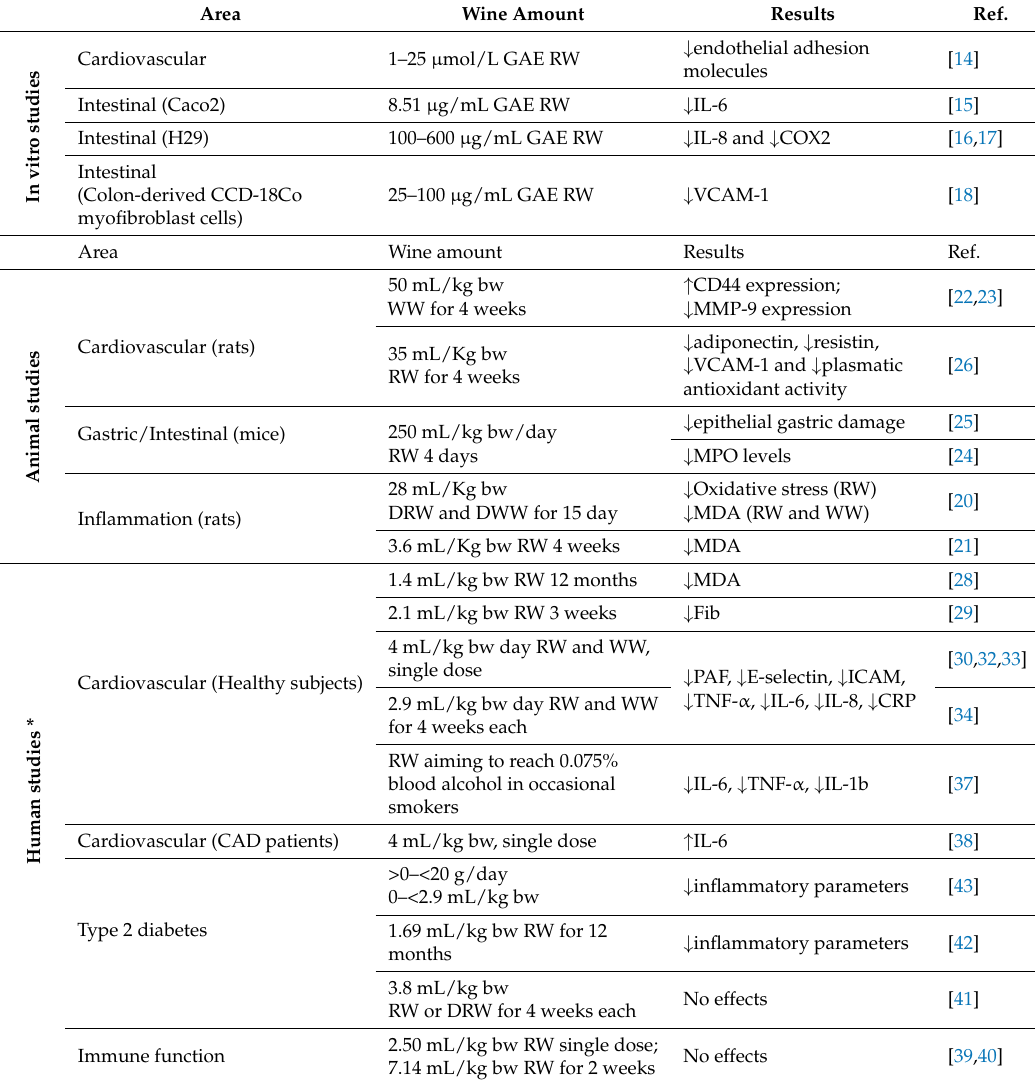
Table 4. Summary of in vitro, animal, and human studies